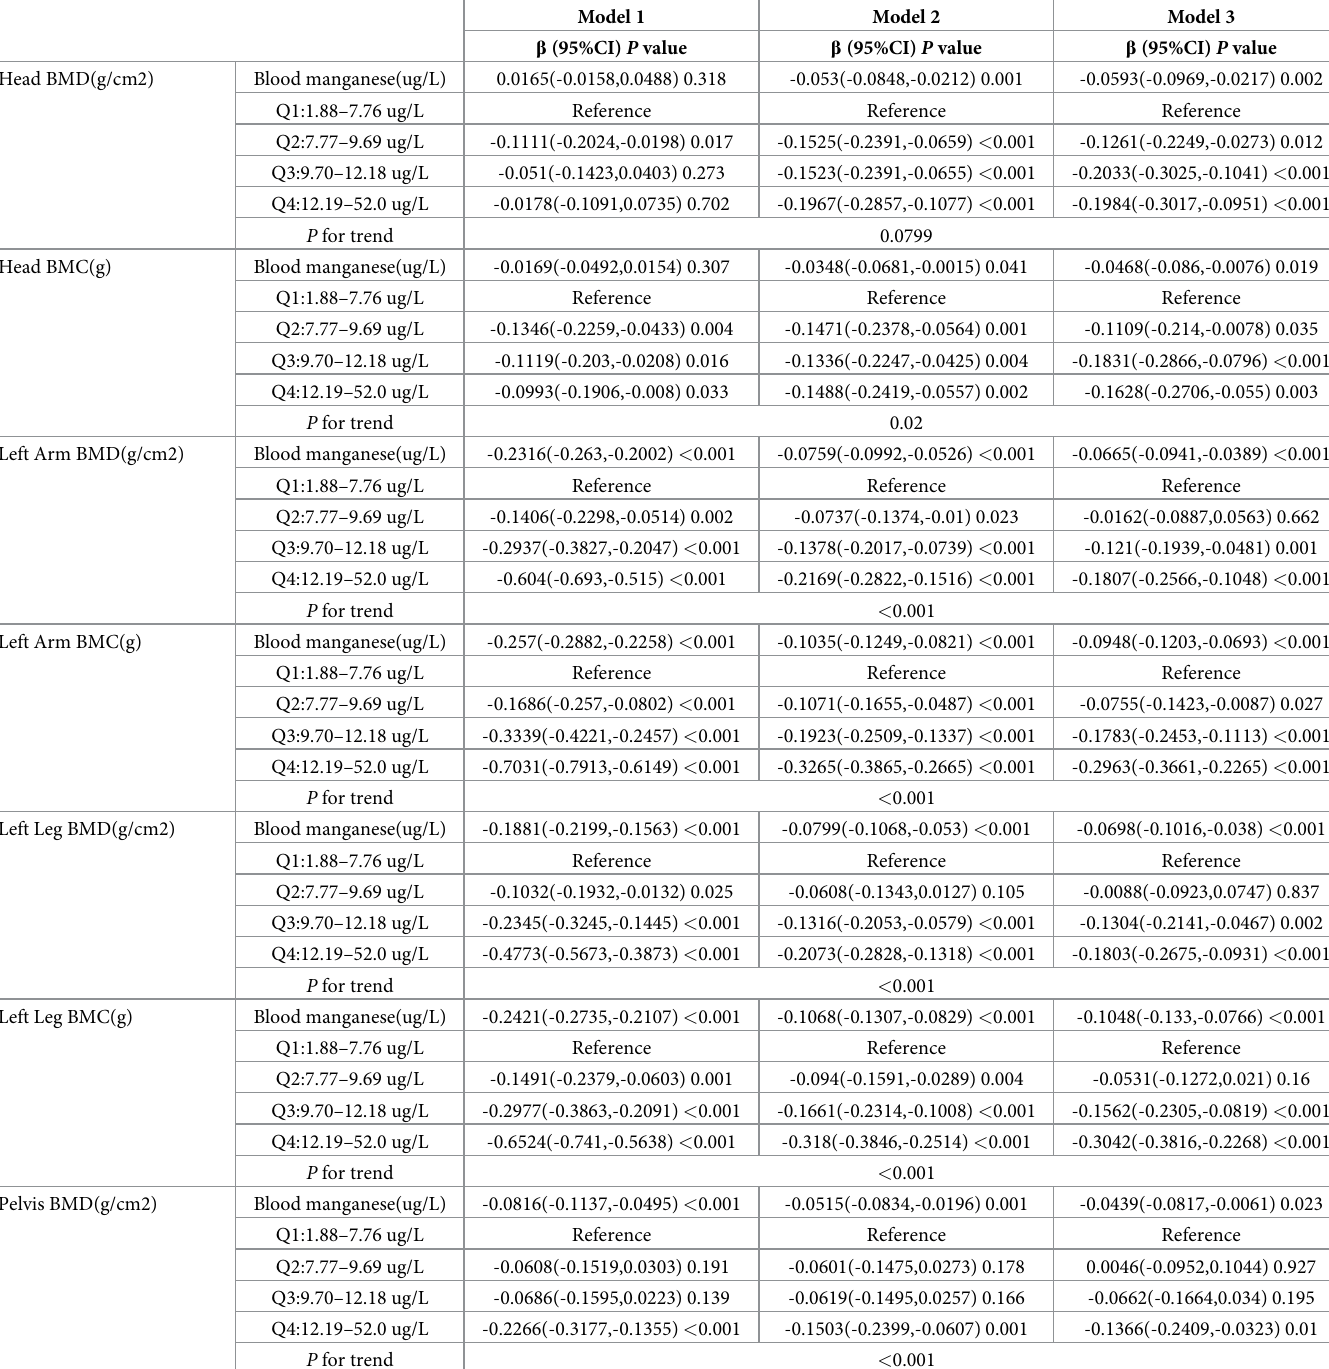
Table 3. The relationship between blood manganese and BMD/BMC in total